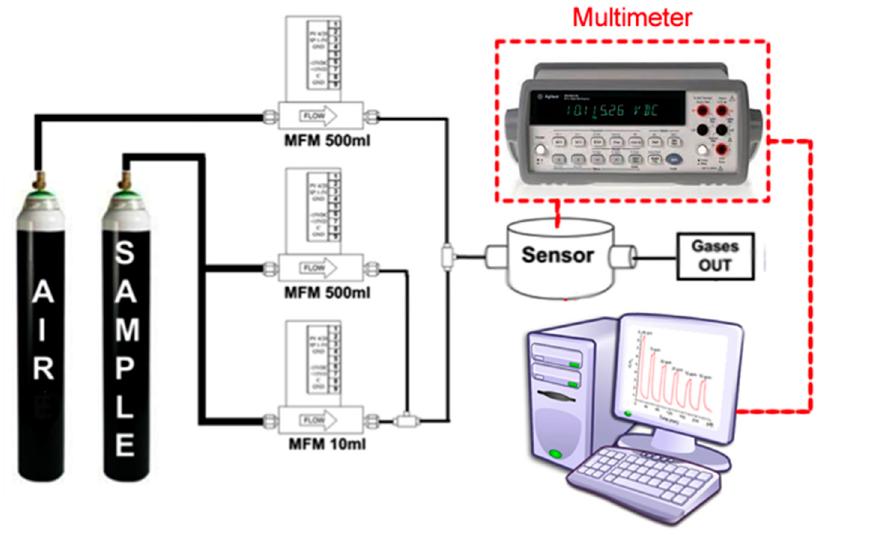
Figure 2. Experimental setup used to measure different concentrations of hydrogen in real